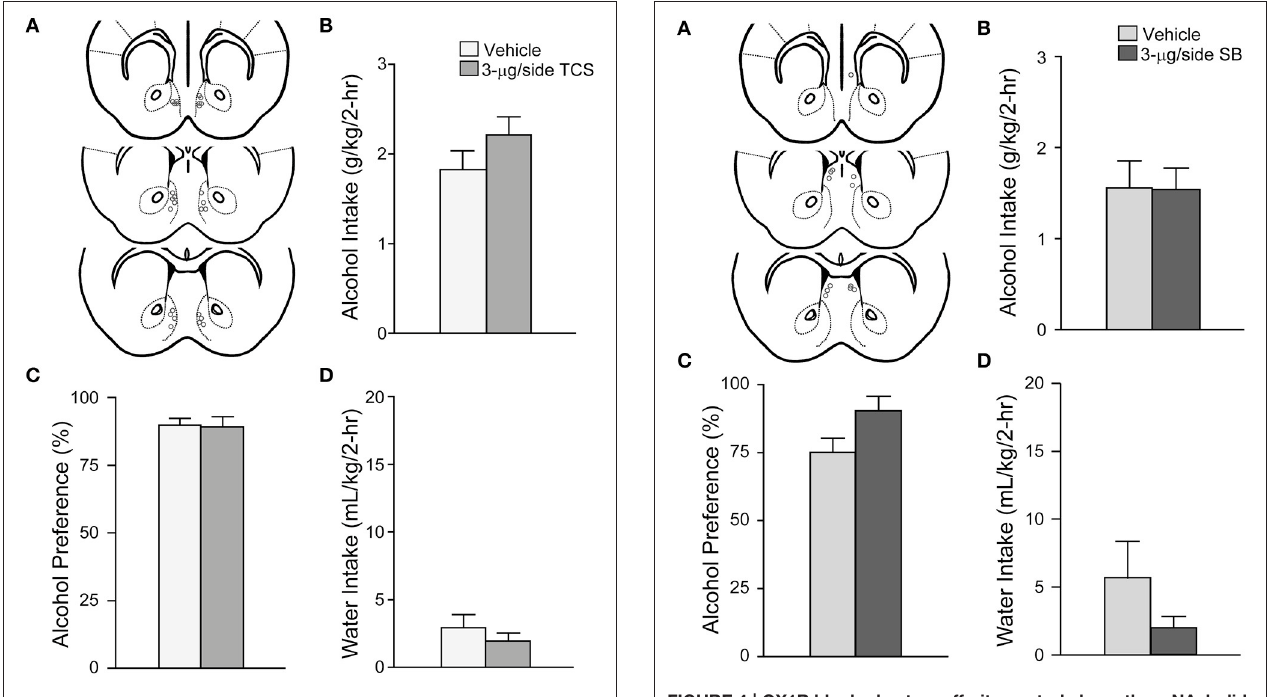
different drinking model, operant responding for alcohol in rats ( n = 8) ( Figure 7A ). In fact, inhibition of OX1Rs within the mNAsh of rats with 3- µ g SB significantly reduced lever-pressing for alcohol, tested within-rat vs. vehicle [ Figure 7B ; t (1 , 7) = 4.17, p = 0.004], with an ∼ 40% reduction, similar to what was observed in mice. OX1R inhibition had no effect on pressing of the inactive lever [ Figure 7C ; t (1 , 7) = 1.34, p = 0.22], although this was already very low. In addition, OX1R inhibition within the mNAsh significantly reduced the number of rewards received [ Figure 7D ; t (1 , 7) = 2.95, p = 0.021] and the amount of alcohol consumed [ Figure 7E ; t (1 , 7) = 2.84, p = 0.025]. Thus, OX1Rs in the mNAsh were critical for promoting alcohol consumption in both mice and